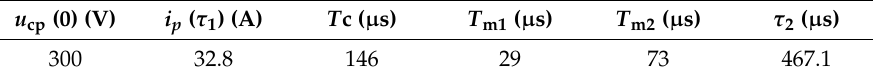
Table 3. The calculation results of the parameters marked in Figures 11 and 12.